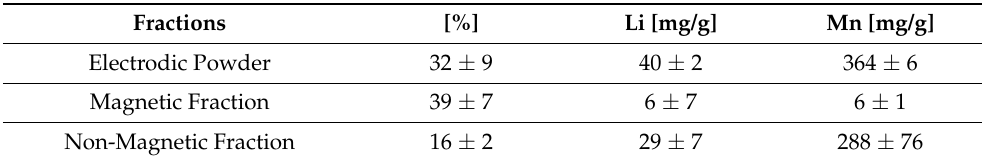
Table 1. Weight distribution and chemical composition of the three fractions obtained after cryome- chanical treatment and dry separation. Fractions [%] Li [mg/g] Mn [mg/g] Electrodic Powder 32 ± 9 40 ± 2 364 ± 6 Magnetic Fraction 39 ± 7 6 ± 7 6 ± 1 Non-Magnetic Fraction 16 ± 2 29 ± 7 288 ±